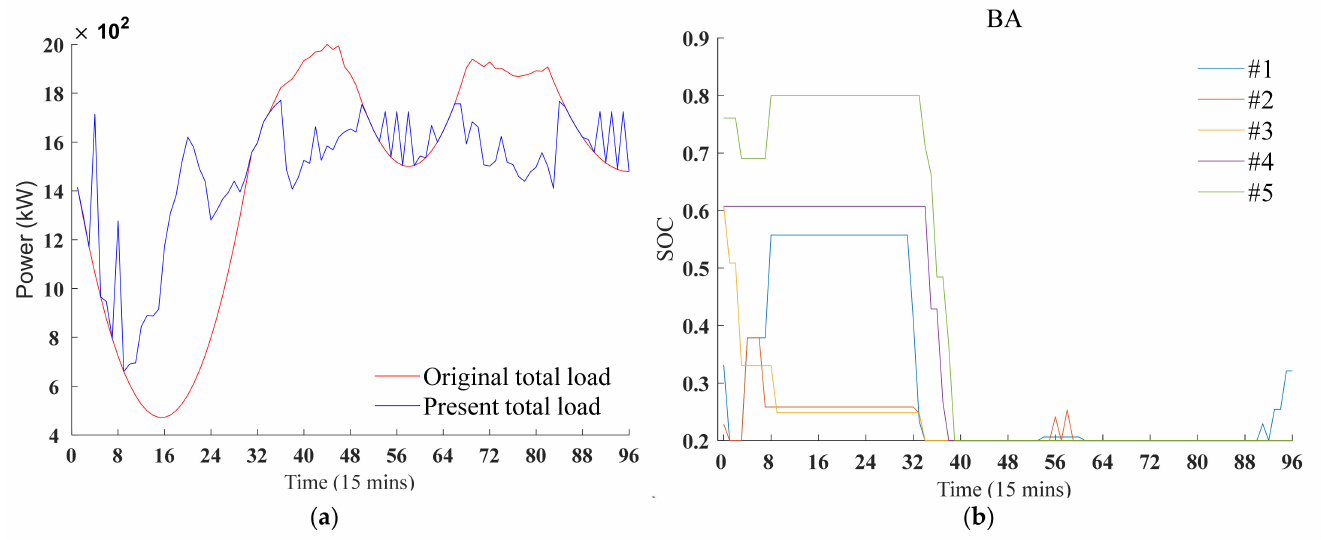
Figure 8. The optimization results by solving the model in [35]. ( a ) The change of the total load curve; ( b ) SOC curve of the lithium battery